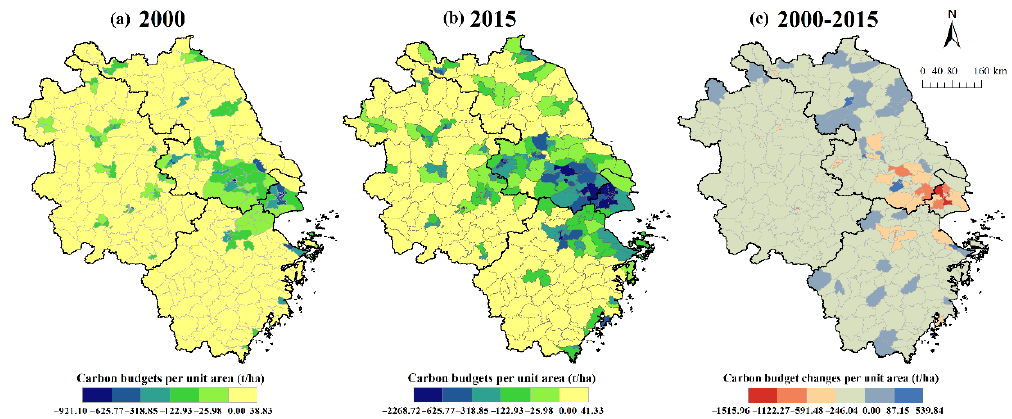
Figure 5. Spatial distribution and changes in the carbon budget per unit area from 2000 to 2015 in the YRD region.